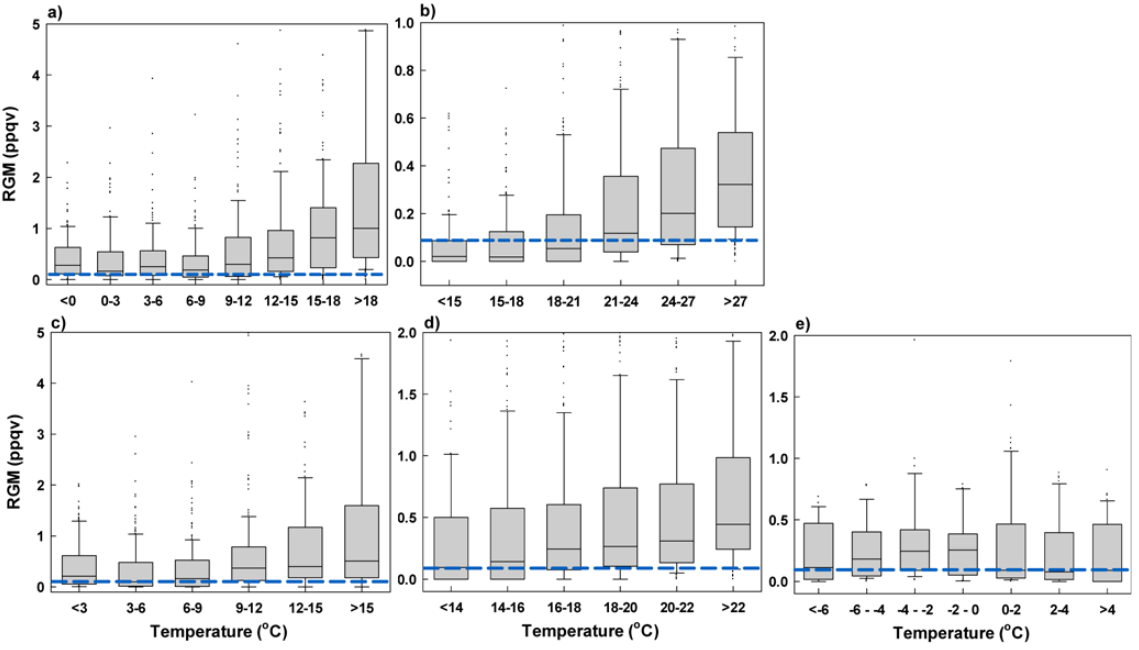
Fig. 9. Daytime mixing ratios of RGM versus temperature at TF (coastal) in (a) springs and (b) summers 2003–2010, at AI (marine) in (c) springs, (d) summers, and (e) winters 2007–2010. The blue dash lines mark the LOD (0.1ppqv).